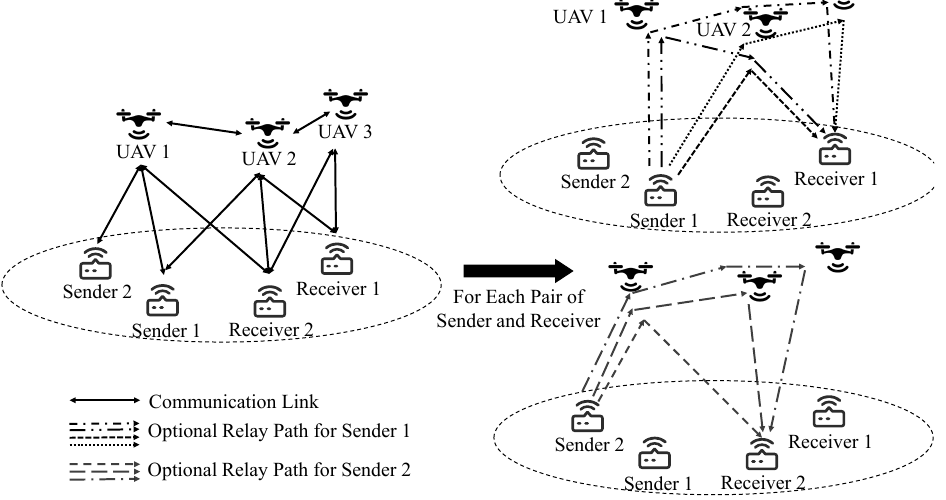
Figure 1. The illustration of the system model, where M = 3, K = 2. The relay path for each pair of users is selected independently, and there can be multiple users and